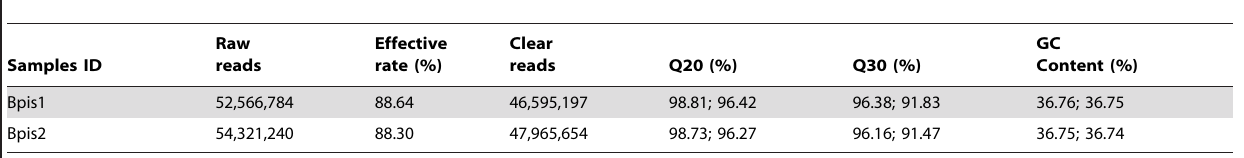
Table 3. Summary of adzuki bean weevil sequencing data output.